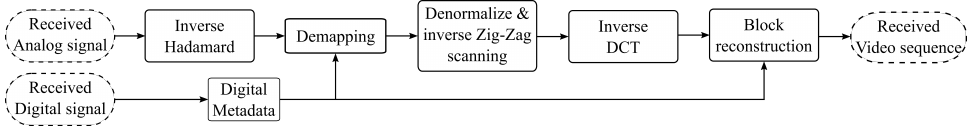
Figure 2. Block diagram of the JSCC-Cast receiver and